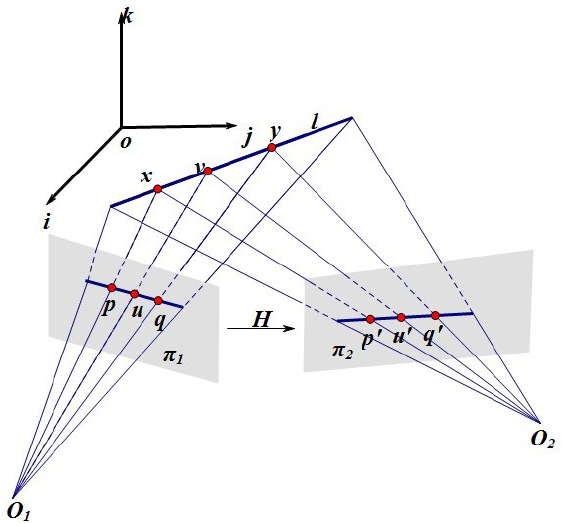
Figure 1. Geometric imaging process. Three points, P, U, Q , of a line in the 3D space are projected as p, u, q and p (cid:48) , u (cid:48) , q (cid:48) into two imaging planes with the focal centers, O O , 2